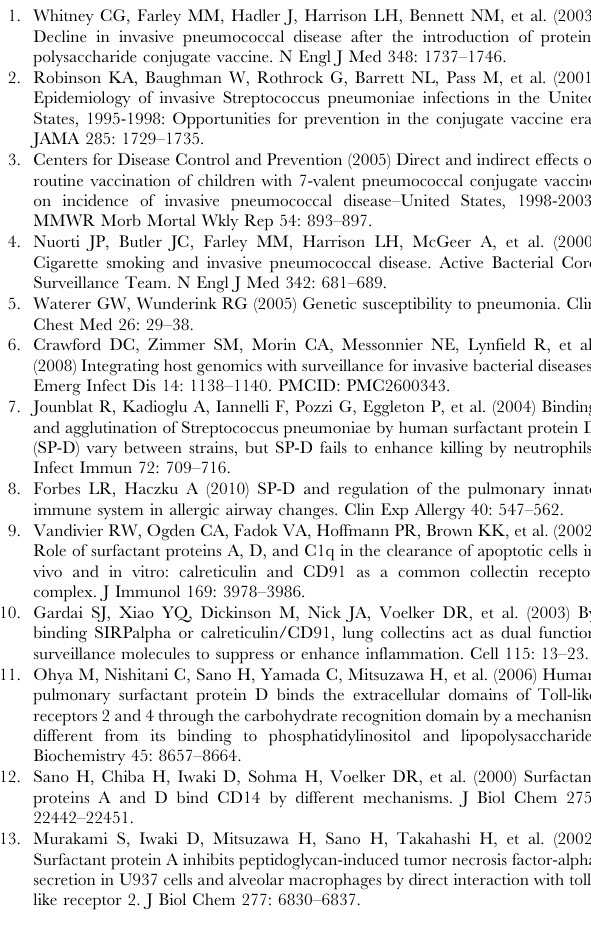
Table S4 tagSNPs in candidate genes associated with pneumonia and meningitis for European-Americans (EA). 25 Cases and 361 Controls with 211 SNPs passing